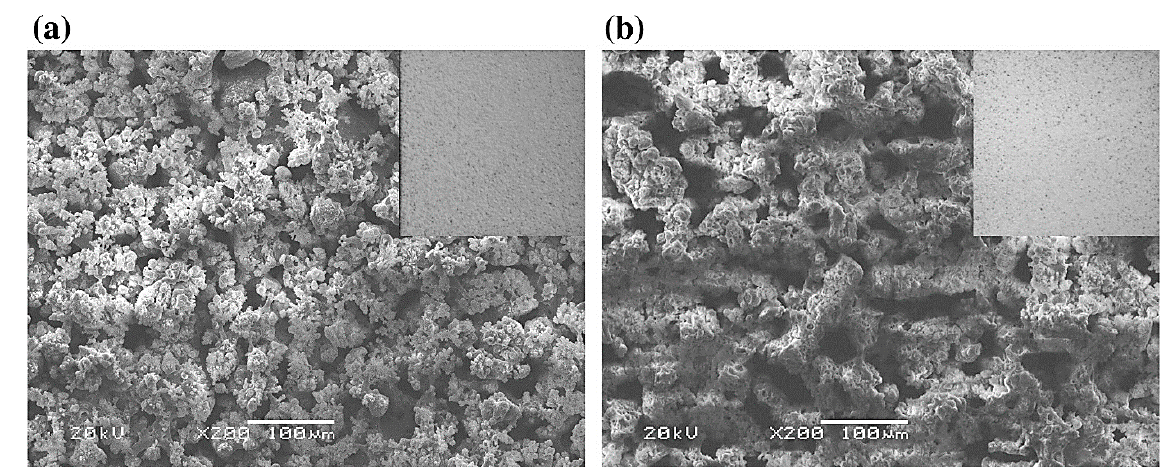
Figure 25. SEM micrograph of coating ( a ) before thermal shock test ( b ) after thermal shock test. Reproduced with permission from [192]. Copyright Elsevier, 2014.